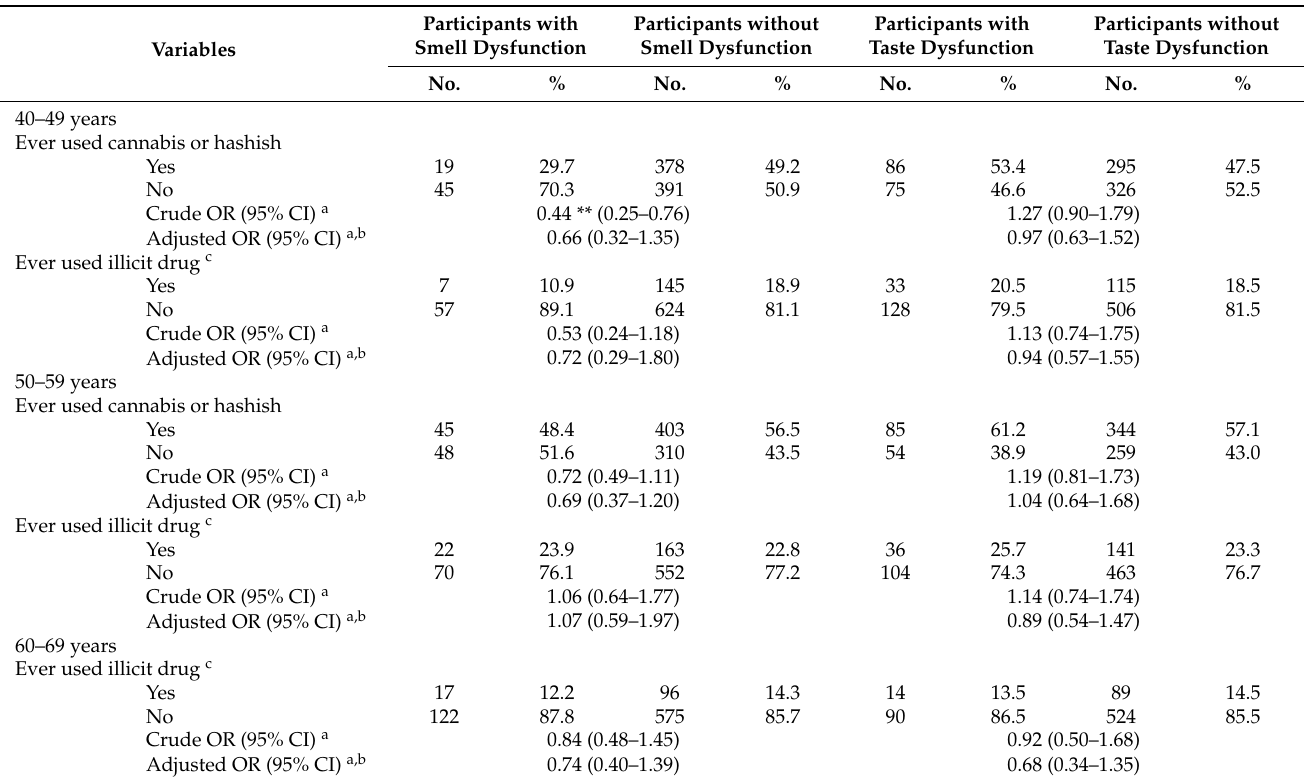
Table 4. Association between cannabis/illicit drug use and smell/taste dysfunction among study participants according to